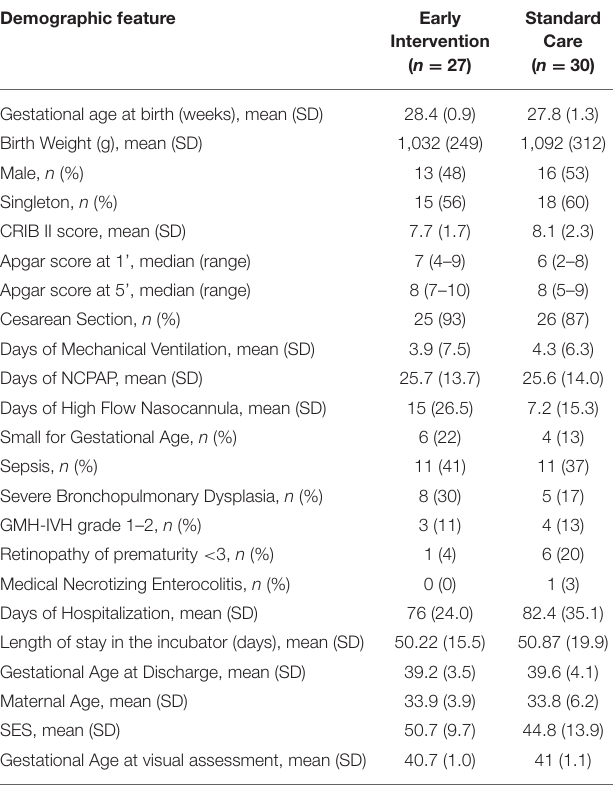
TABLE 1 | Infants and maternal